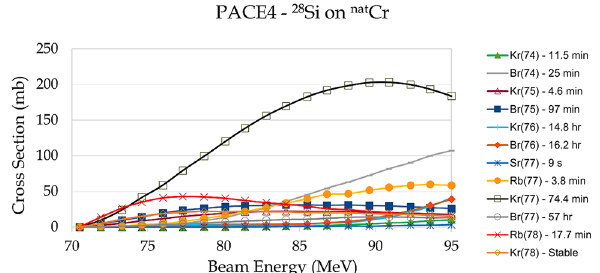
Figure 1. PACE4 predicted cross sections for 77 Br, precursors and contaminants as a function of laboratory bombarding energy for the 28 Si + nat Cr reaction. The dominant products are 77 Rb and 77 Kr, which decay to 77 Br. The mass-76 isobars are not strongly